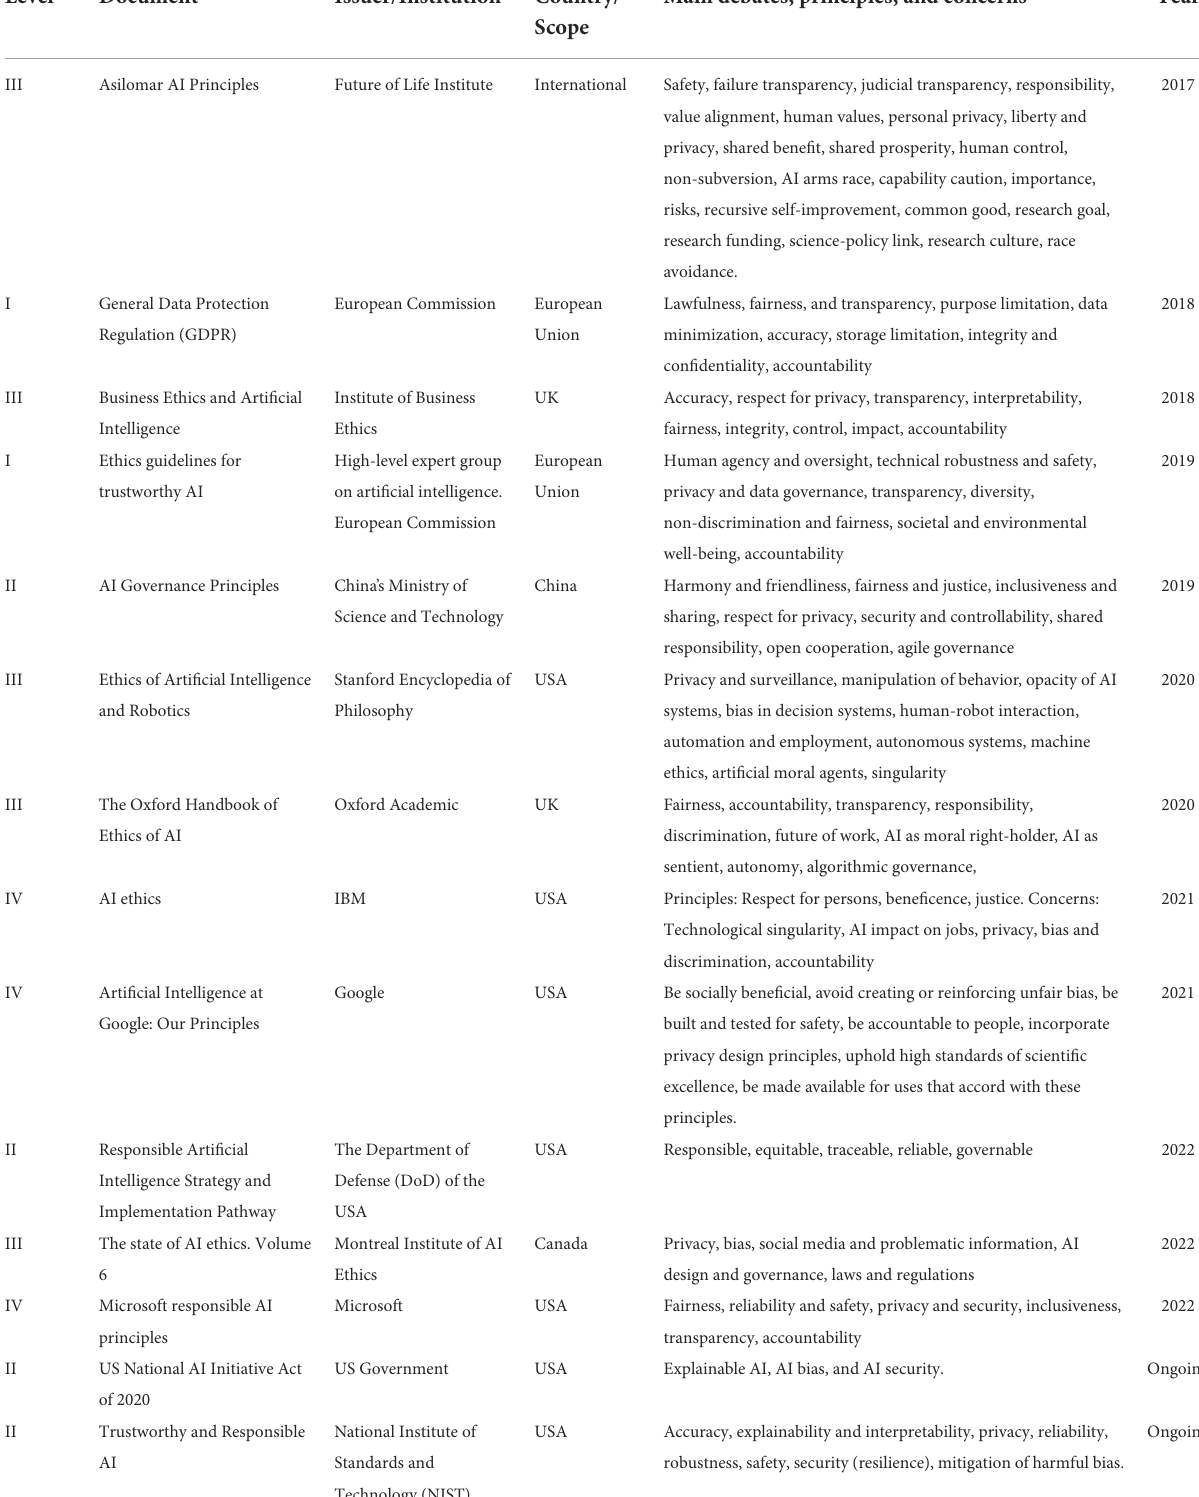
TABLE 3 Main debates, principles, and concerns over AI ethics in gray